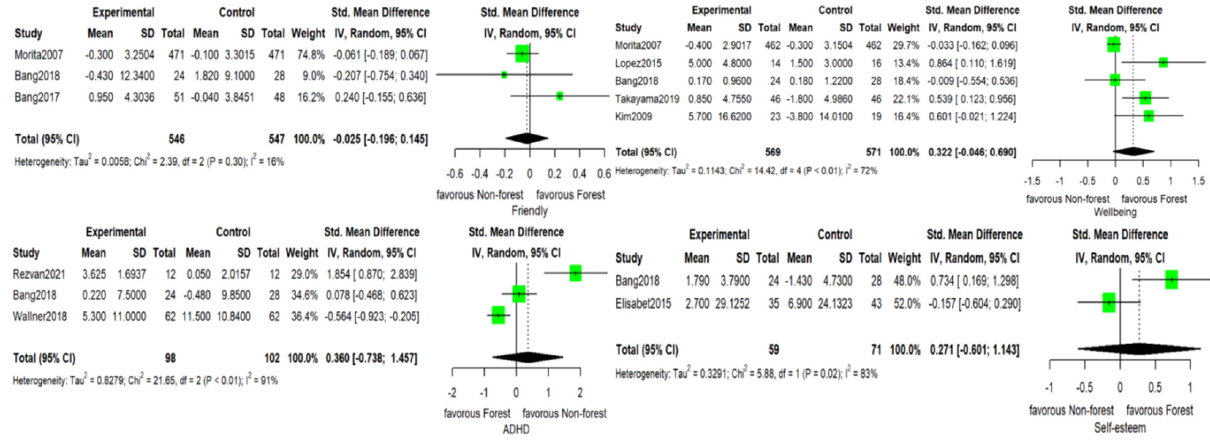
Figure 3. Forest plot of the results of a random-effects meta-analysis shown as mean differences in well-being-related psychological symptoms with 95% CIs. CI, confidence interval; SD, standard deviation; ADHD, attention-deficit/hyperactivity disorder.